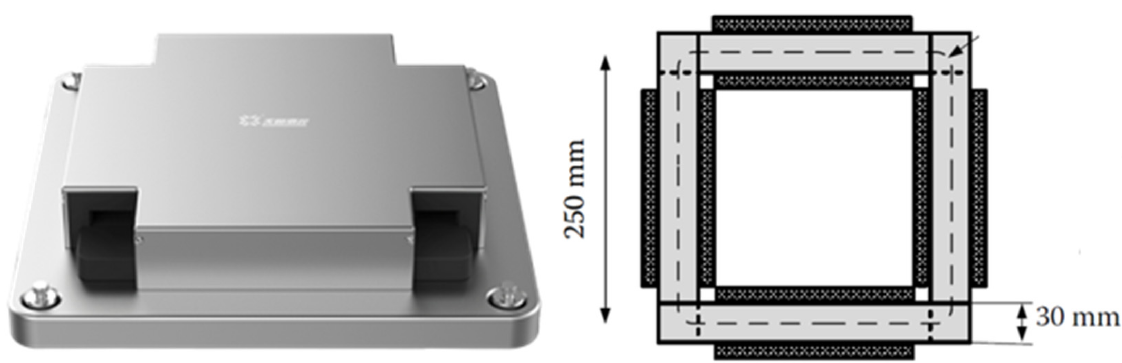
Figure 2. Setup and the schematic diagram of the 25 cm Epstein tester.